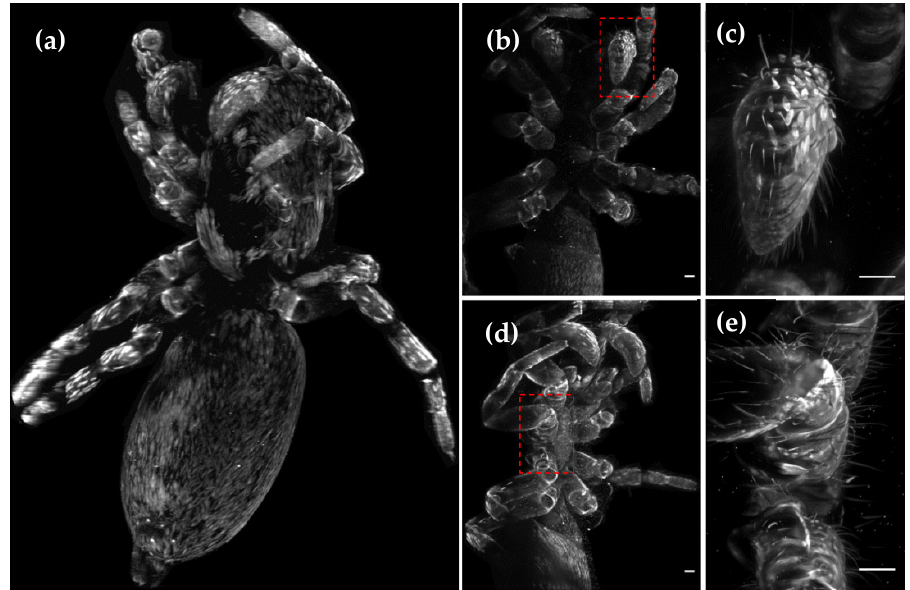
Figure 2. Maximum intensity projection of the auto-fluorescence from a Salticus scenicus spider. ( a ) After stitching of two 3D stacks and multi-view fusion of eight views, 45° apart. Images acquired with a 4× objective, 488 nm excitation and 520 long pass filter. A 3D volume render is shown in Video S1. ( b ) Maximum projection single view with a 4× objective and ( c ) detail from of the pedipalp tip obtained with a 16× objective ( e ) detail from ( d ) of the articulations obtained with 16× objective. Scale bars: 100 microns.